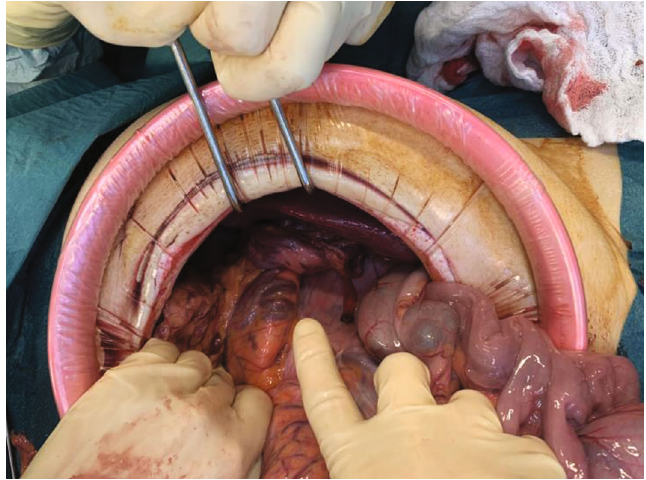
Figure 4: Volvulus of the